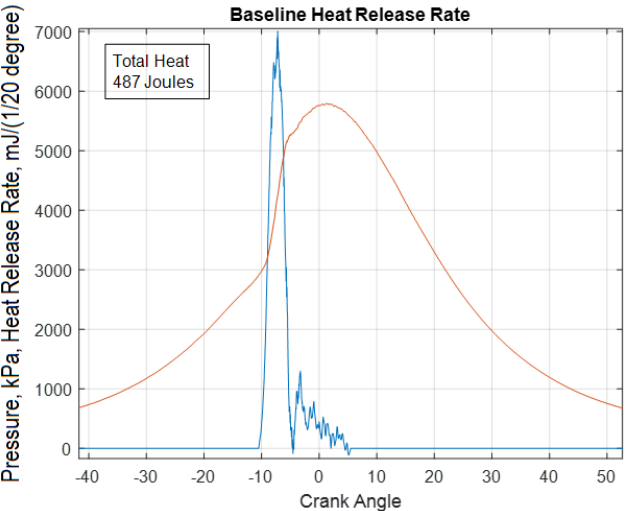
Figure 14. Instantaneous heat release rate for BSL Case 1 along with the corresponding cylinder pressure. The premixed combustion looks sharper than what is normally reported in the literature, partly due to the low-pressure fuel injection and partly due to the over-advanced timing.